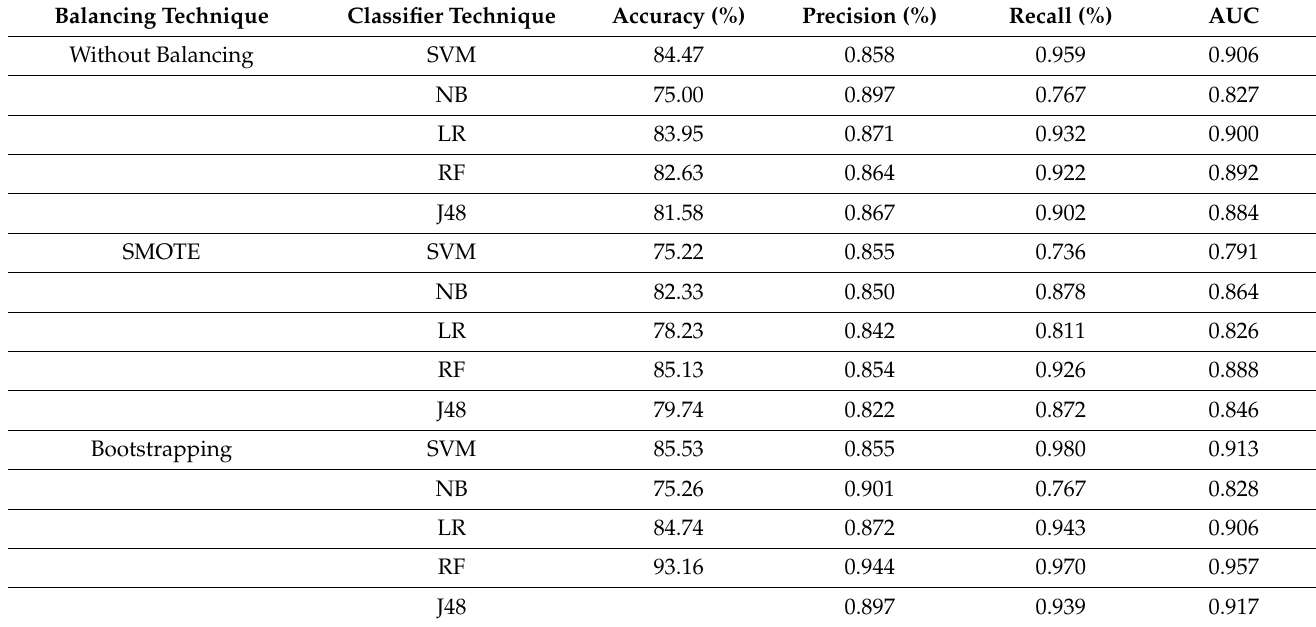
Table 7. Performance of the classifiers using the Relief